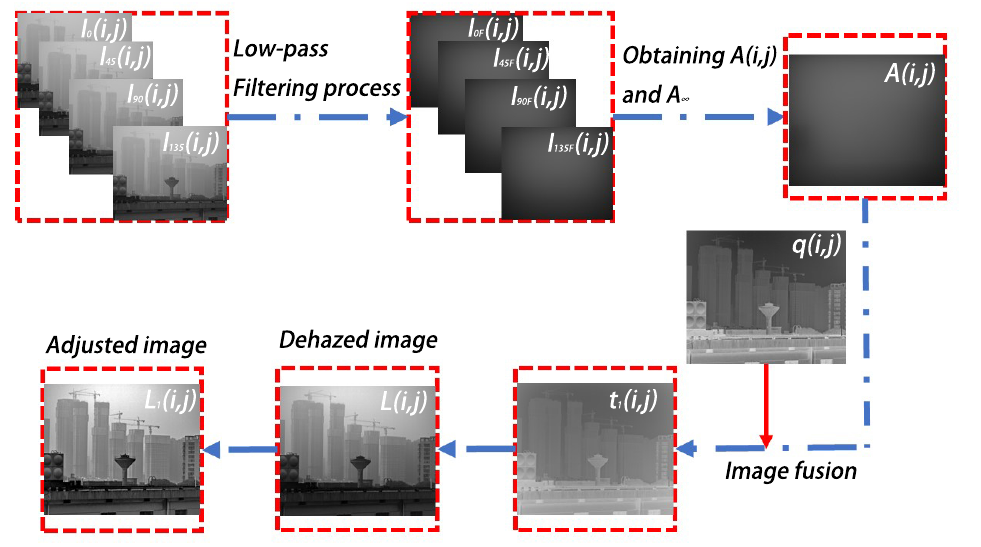
Figure 4. The flowchart of the proposed